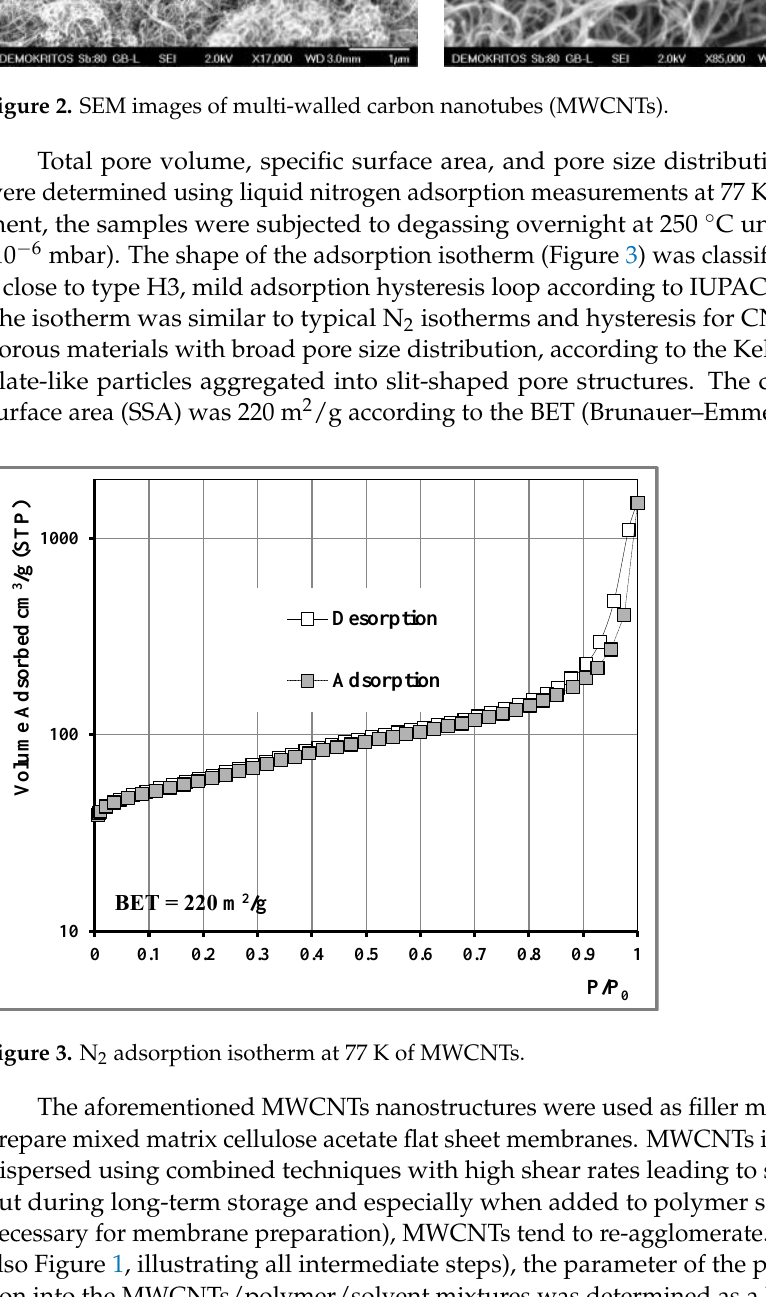
Figure 3. N 2 adsorption isotherm at 77 K of MWCNTs.